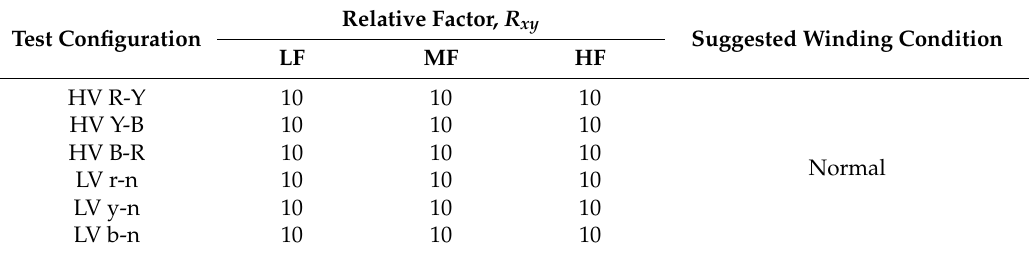
Table 4. Relative factors at different frequency regions/test configurations and the suggested winding